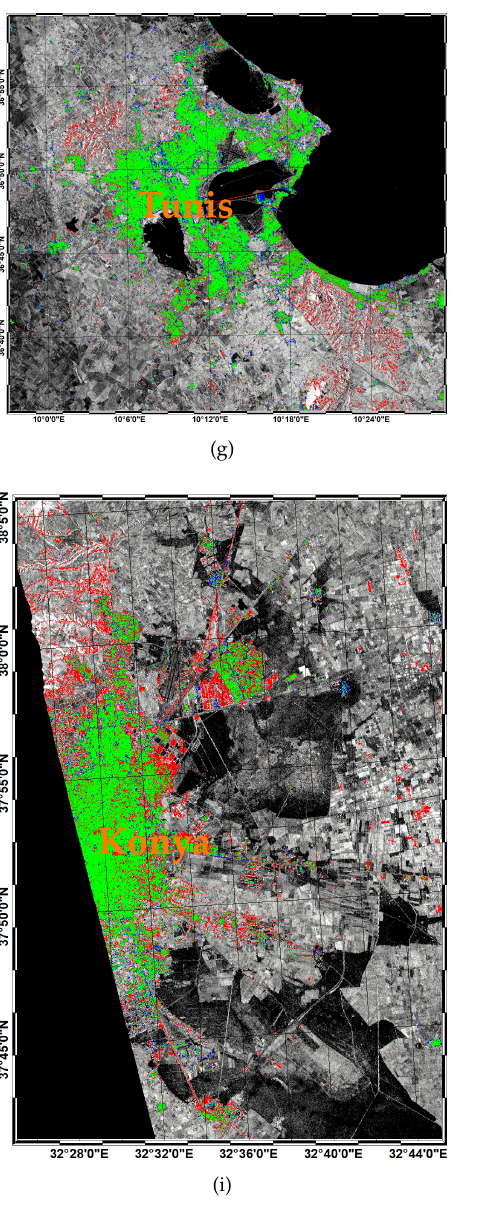
Figure 3. Sentinel-1 (S-1) Buildings Map (S1BM) versus the Global Urban Footprint (GUF) for the Egypt Figure 3. S1BM versus the GUF for the Egypt (a,b), Israel (c,d), Portugal (e,f) Tunisia (g,h) and ( a , b ), Israel ( c , d ), Portugal ( e , f ), Tunisia ( g , h ), and Turkey ( i , j ) test cases. Left column: confusion maps Turkey (i,j) test cases. Left column: confusion maps (Red: buildings detected only by S1BM, Green: (Red: buildings detected only by S1BM, Green: overlap of detected buildings by S1BM & GUF, blue: overlap of detected buildings by S1BM & GUF, blue: buildings detected only by GUF, background: S1 buildings detected only by GUF, background: S1 backscattering intensity). Right column: examples of backscattering intensity). Right column: examples of S1 VV intensity datasets. S1 VV intensity